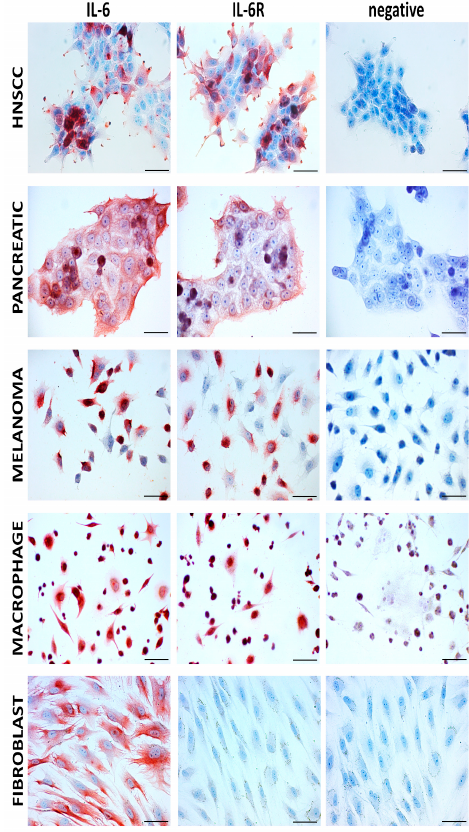
Figure 2. Immunocytochemical analysis of IL-6 and IL-6 receptor in cell lines representing the malignant (several types) and the stromal component of tumours using immunoperoxidase